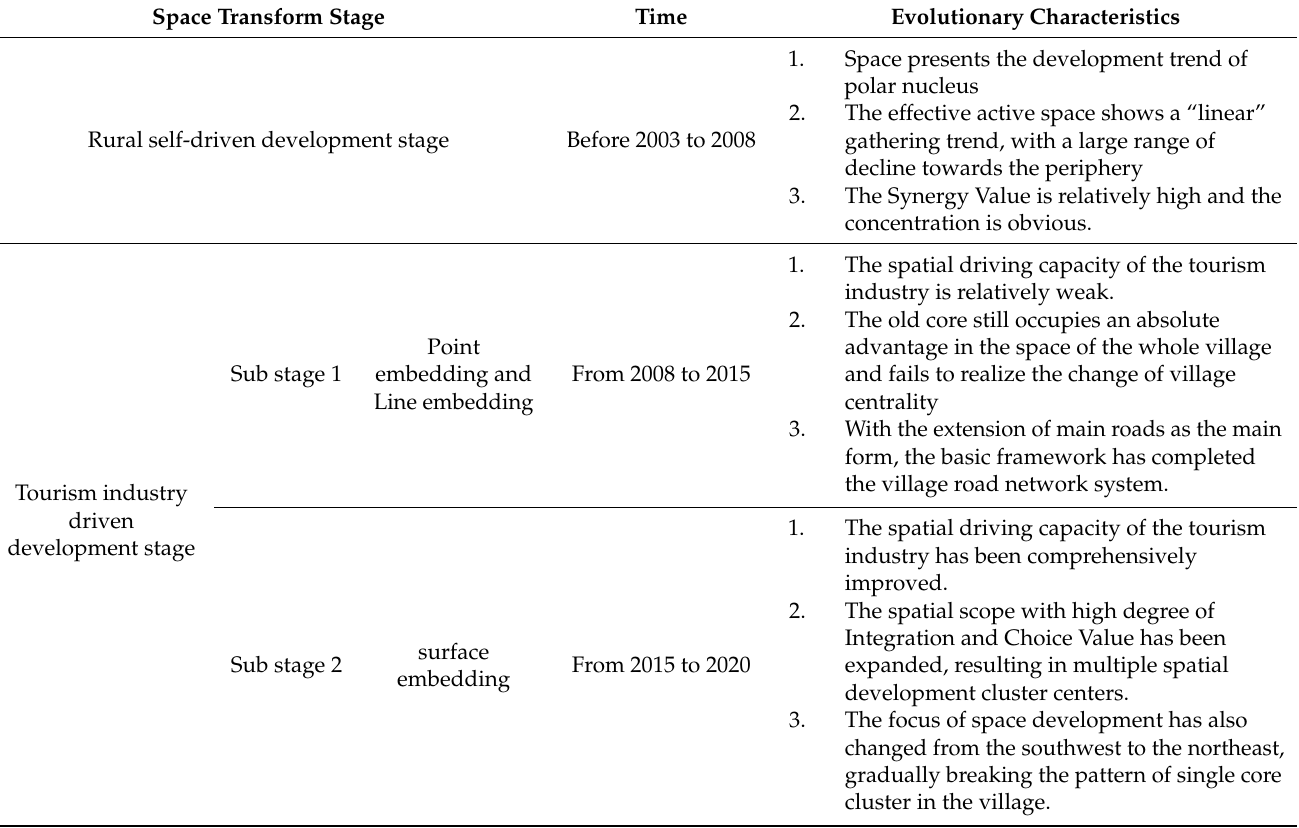
Table 2. Evolution phase of spatial transform in Matao